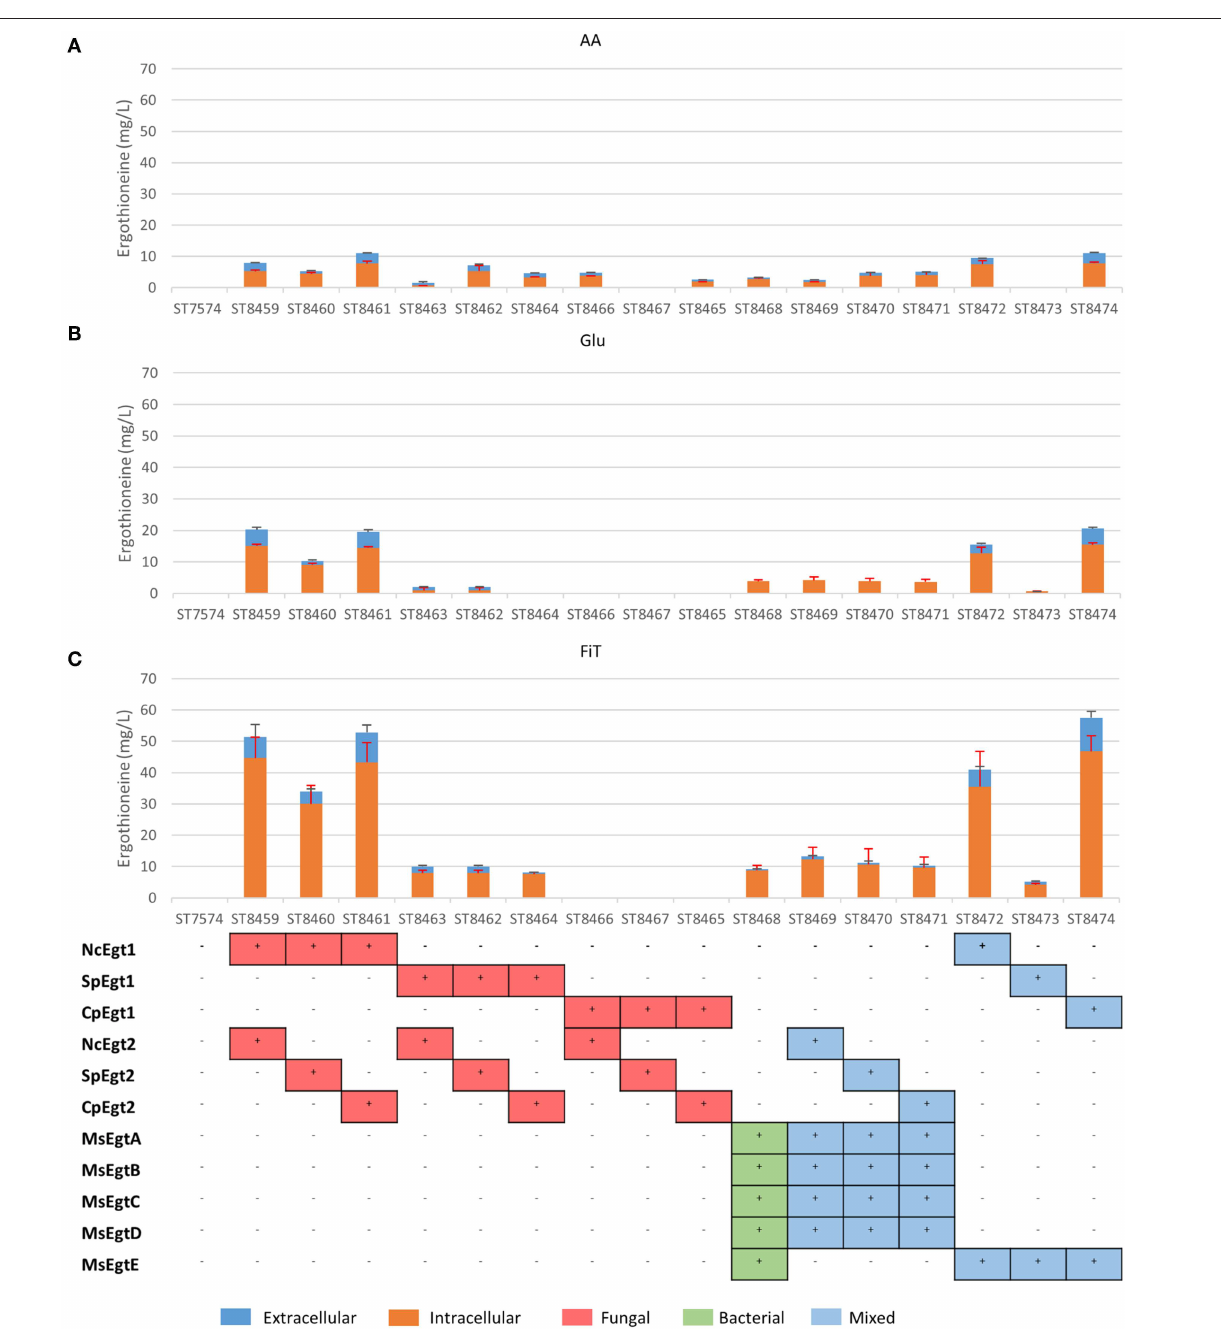
FIGURE 2 | Ergothioneine production in strains with different ERG pathway combinations on three variations of synthetic complete medium: (A) AA: 20 g/l glucose and 1 g/l of each L-His, L-Met, and L-Cys, (B) Glu: 40 g/l glucose, (C) FiT: 60 g/l EnPump substrate for slow glucose release to simulate fed-batch conditions.